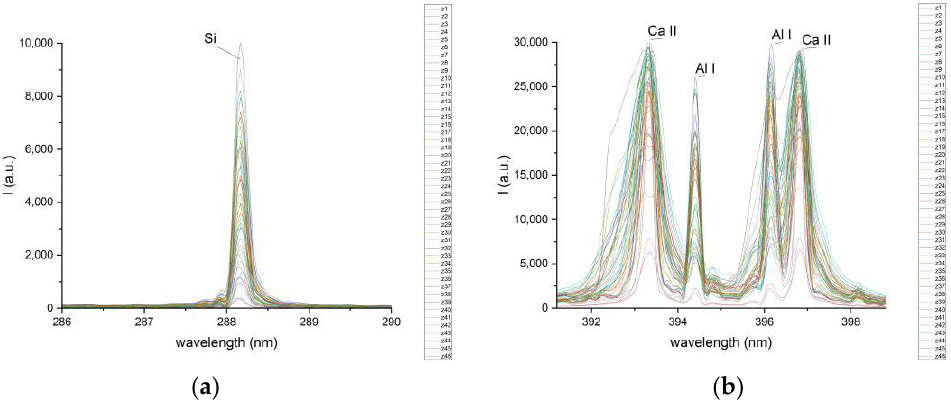
Figure 5. LIBS spectra for ( a ) Si line and ( b ) Ca and Al lines.